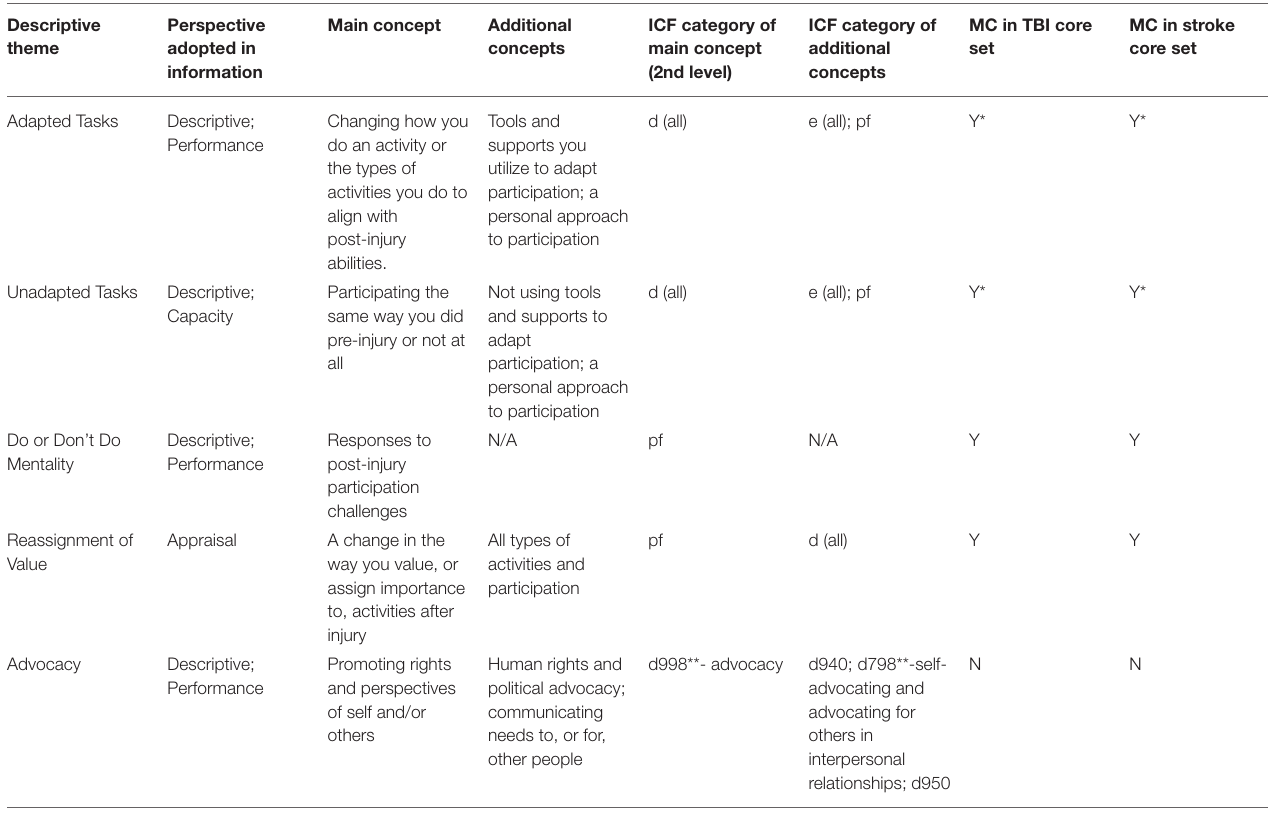
TABLE 6 | ICF linking to themes from how pwABI approach